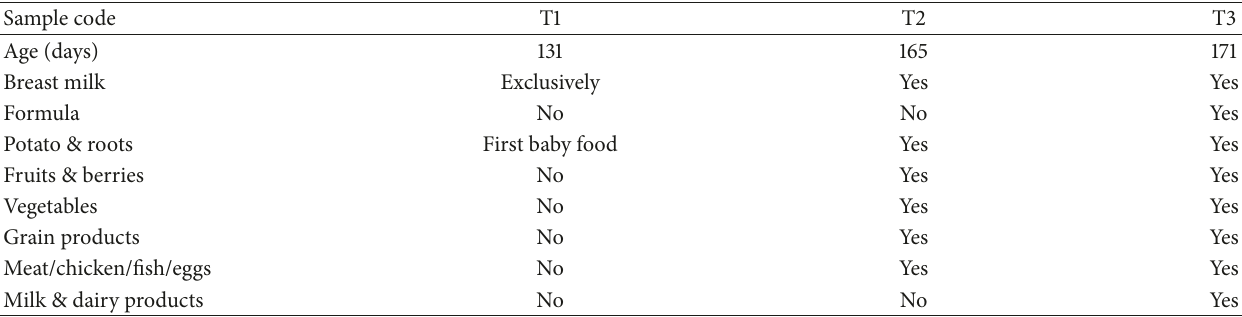
Table 1: Overview of the infant